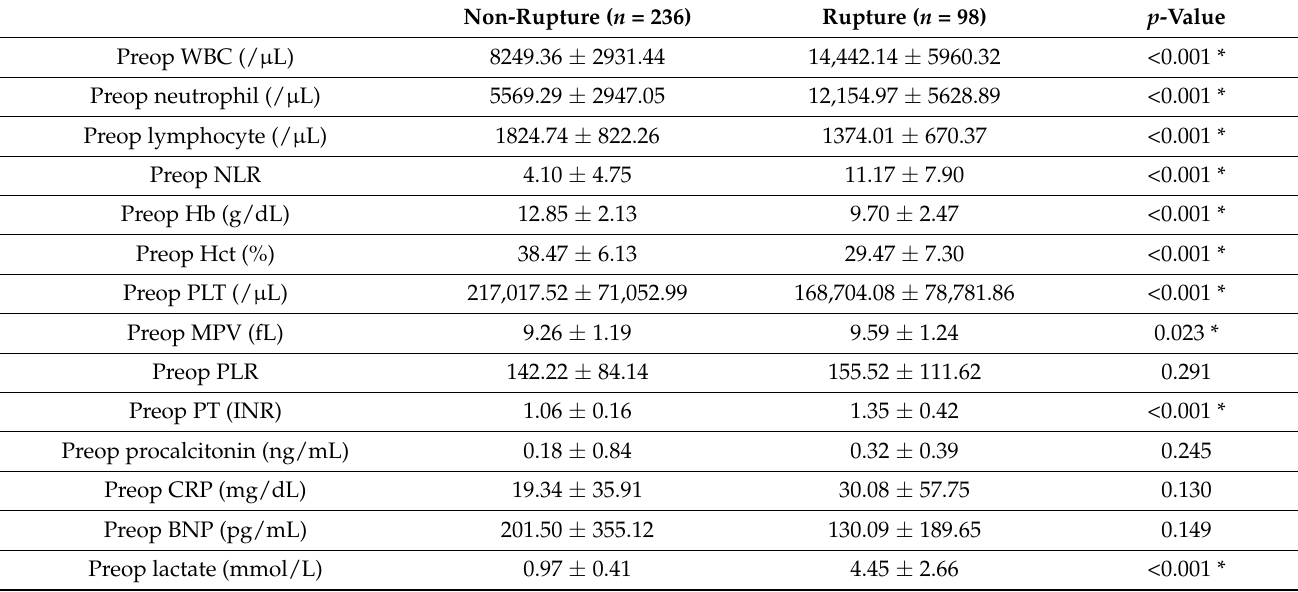
Table 5. Laboratory data according to the presence of